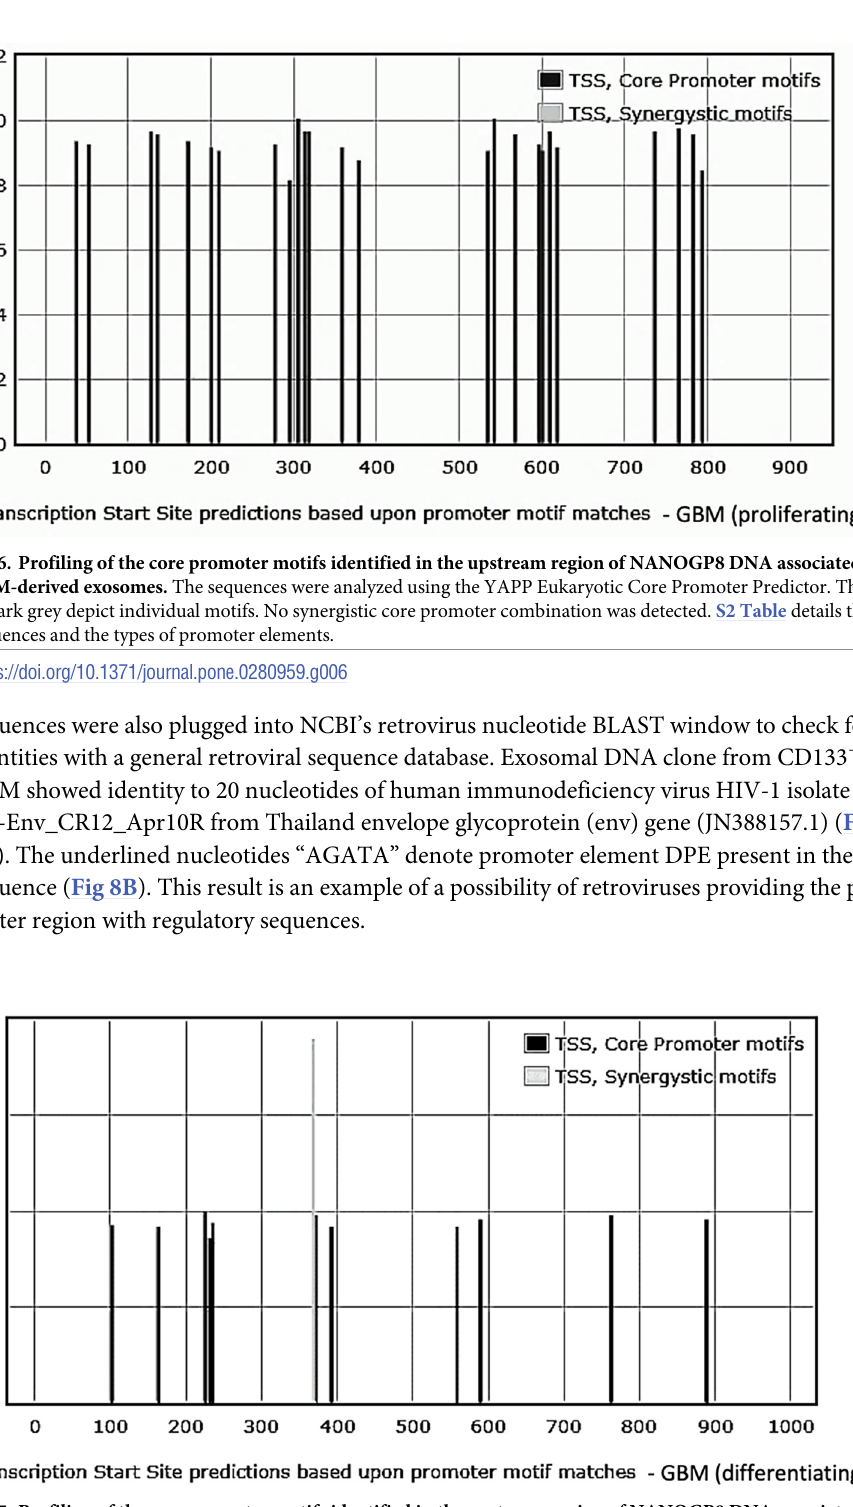
Fig 7. Profiling of the core promoter motifs identified in the upstream region of NANOGP8 DNA associated with CD133 - derived exosomes. The sequences were analyzed using the YAPP Eukaryotic Core Promoter Predictor. A singular synergistic core promoter motif is denoted in light gray, whereas the bars in dark grey depict individual motifs. S3A and S3B Table details the sequences and the type of promoter